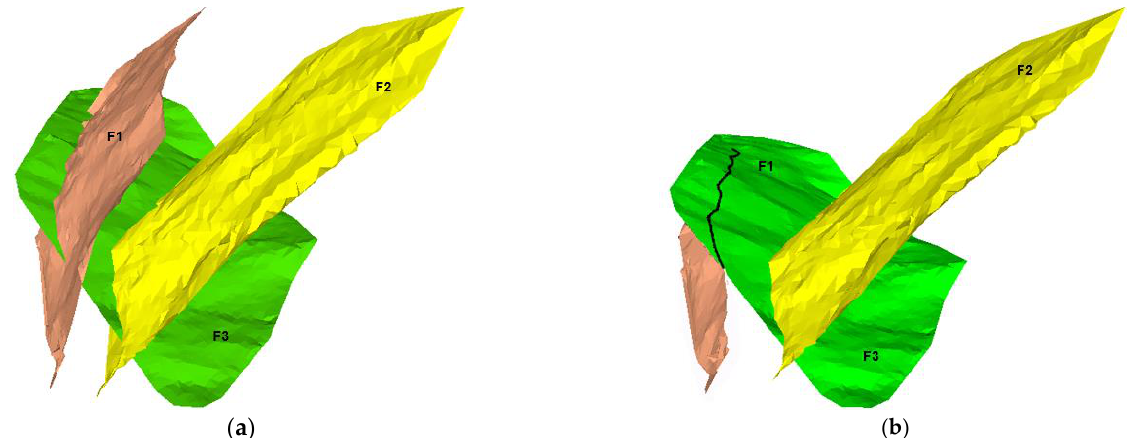
Figure 12. Example diagram of truncation of intersecting fault surfaces. ( b ) is the truncating result of ( a ).